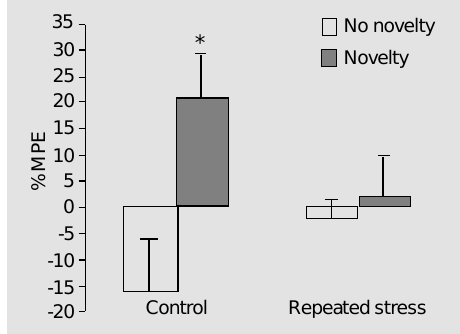
Figure 1 - Effect of exposure to a new environment on tail-flick la- tencies plotted as mean (± SEM) % maximum possible effect (%MPE) (N = 8-10 rats/group). Control and repeatedly re- strained animals were subdi- vided into 2 other groups: with and without exposure to nov- elty, and tail-flick latencies were measured before (baseline) and after exposure to a novel envi- ronment. *P<0.05 compared to animals not exposed to novelty (Student t -test